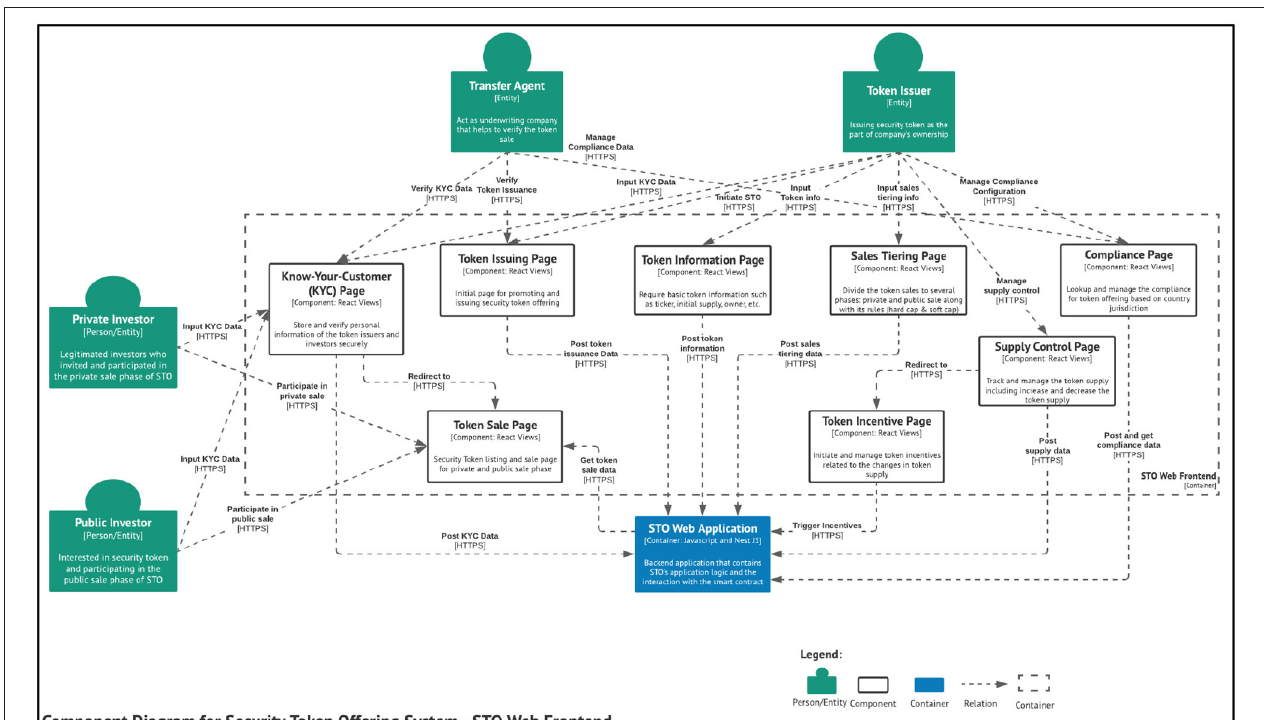
FIGURE 1 | Component diagram for STO web